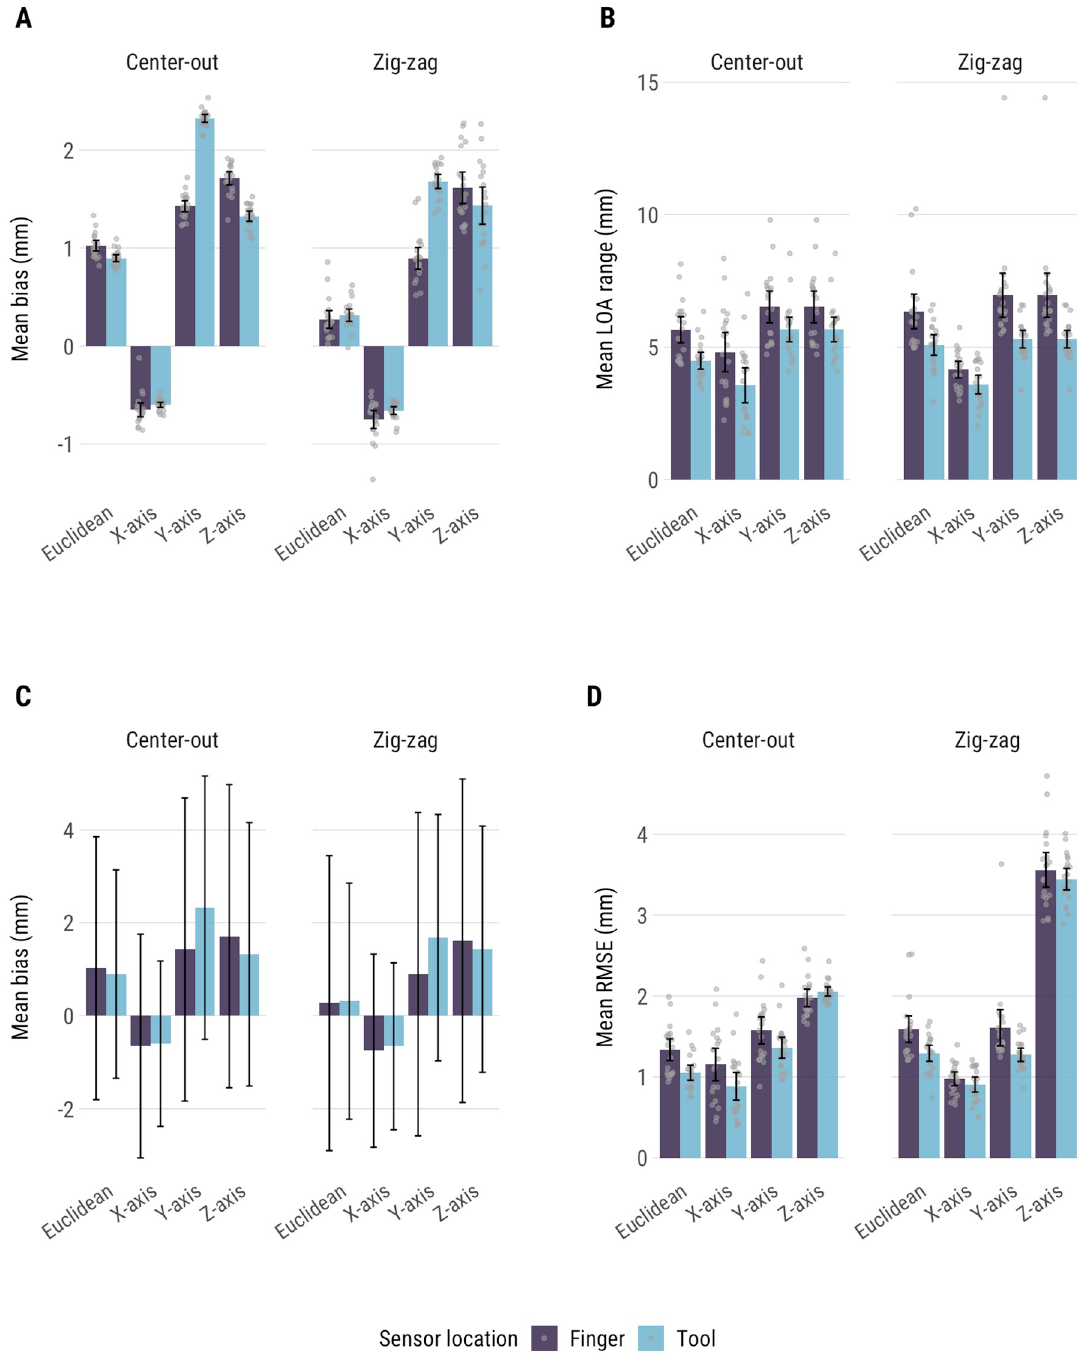
Fig 3. (A) Mean bias across the twenty trials, for each of the four tasks. Error bars are 95% confidence intervals and grey points are bias values for each trial (same for graphs C and D). (B) Ranges of limits of agreement across trials, for each of the four tasks. (C) Mean bias (bars) and limits of agreement (error bars) presented together. (D) Mean RMSE values across trials, for each of the four tasks.